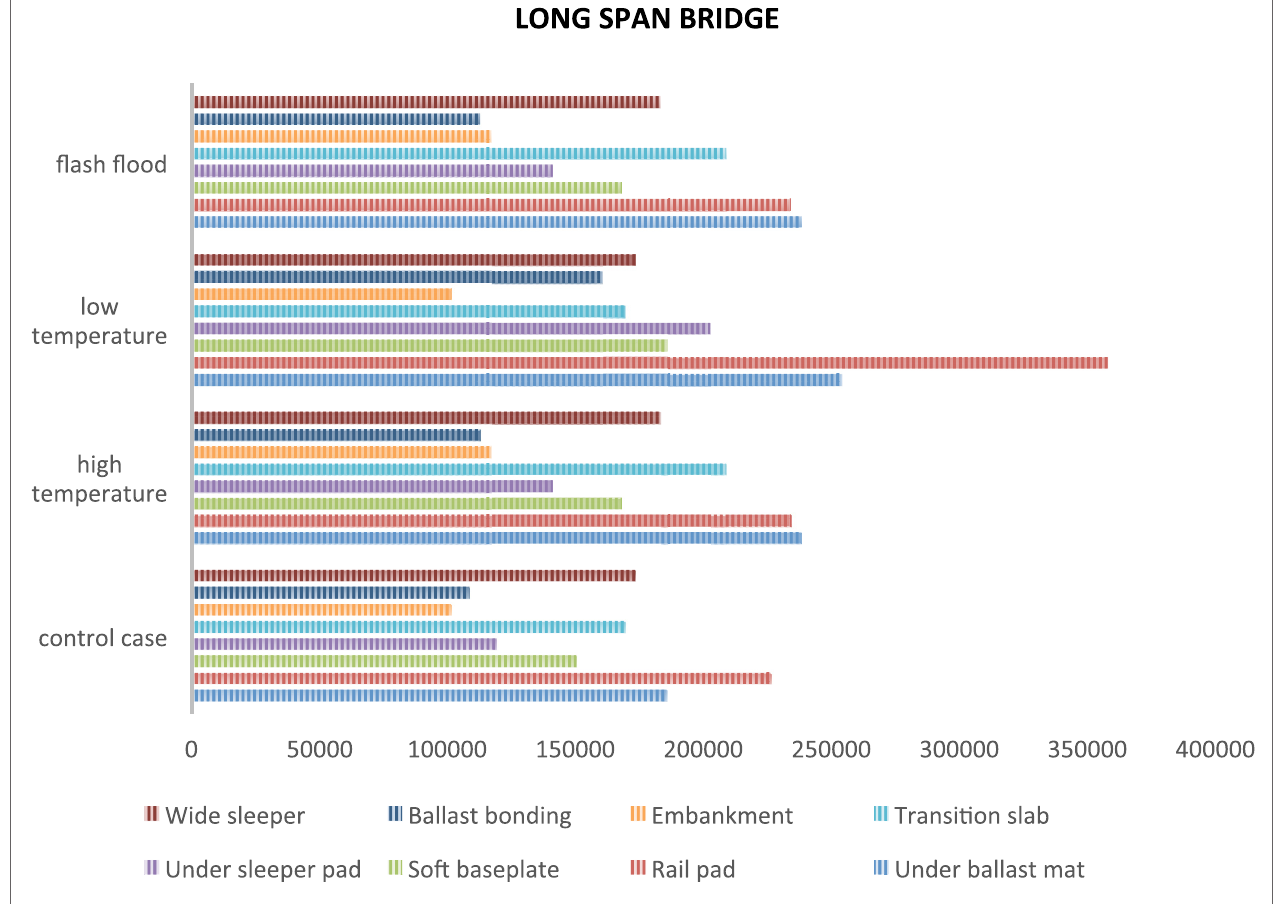
Figure 5 | Net present value (NPV) of total cost of bridge approach treatment methodologies for long-span bridge in four